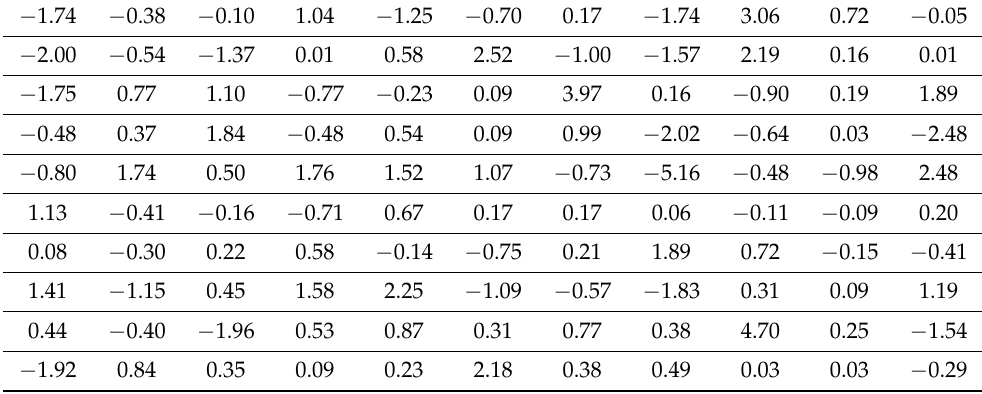
Table A4. Hidden layer weights (11 input × 10 hidden neurons).